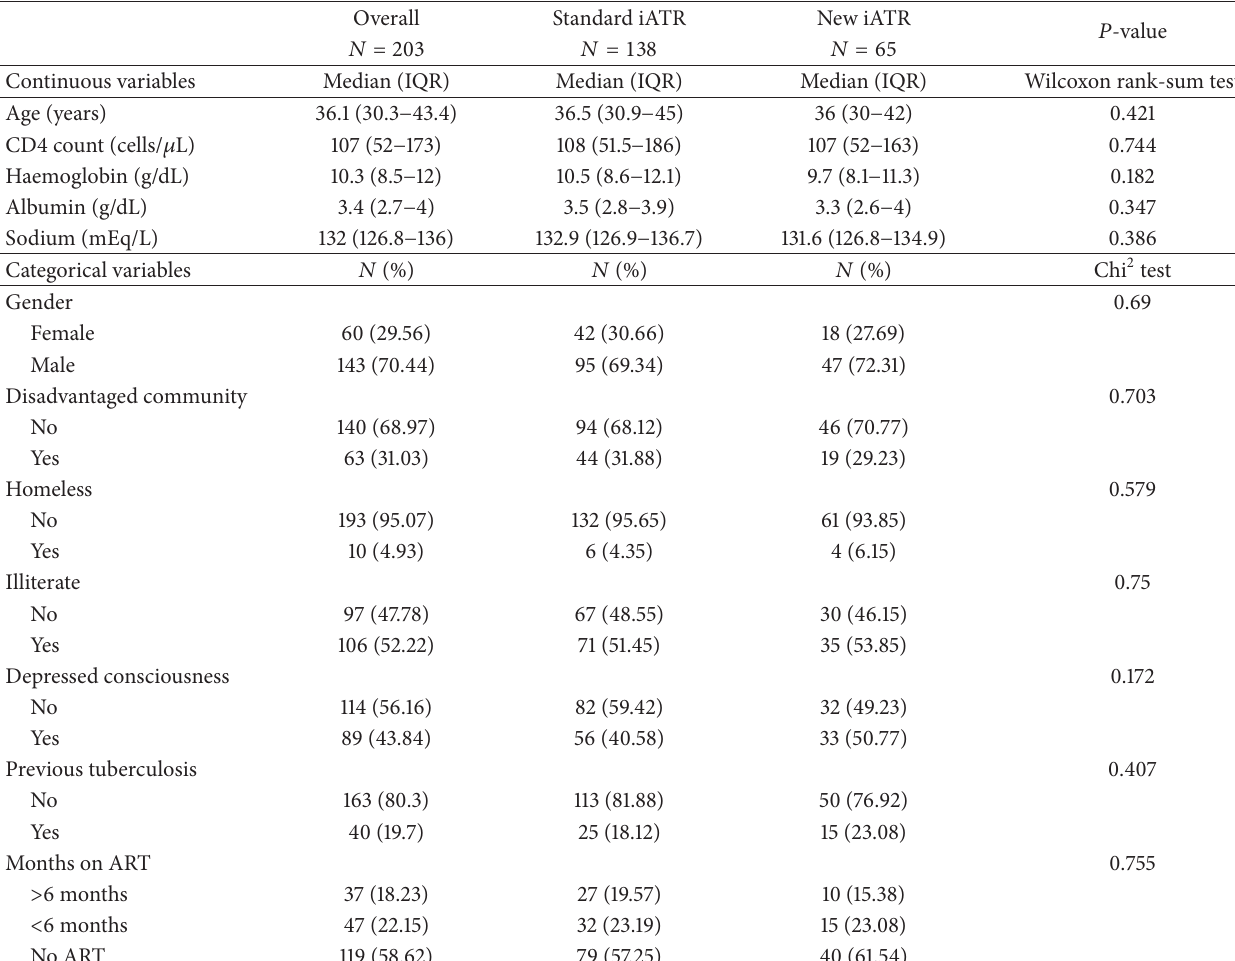
Table 1: Baseline characteristics and differences between patients who received the standard antituberculous regimen and those who received a new antituberculous regimen with better cerebrospinal fluid